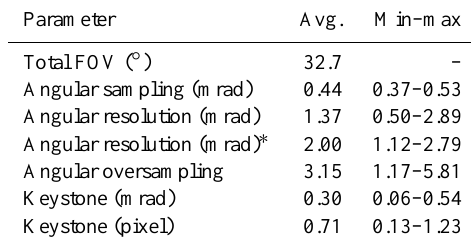
Table 4. Summary of the geometric across-track properties of the specMACS VNIR sensor excluding the first 30